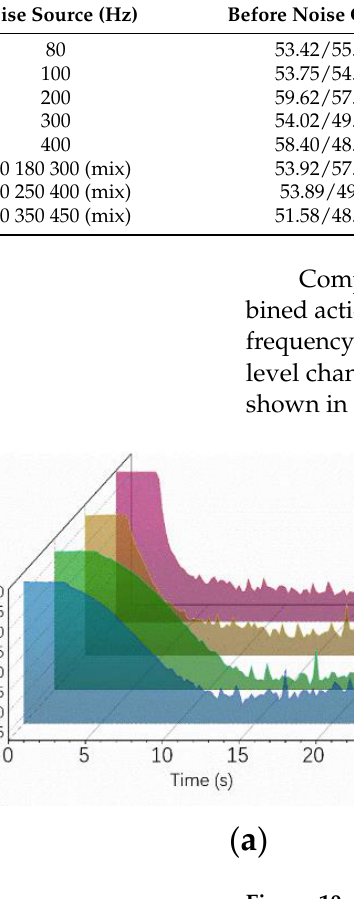
Table 3. 4-channel fractional-order ANC noise cancellation statistics.